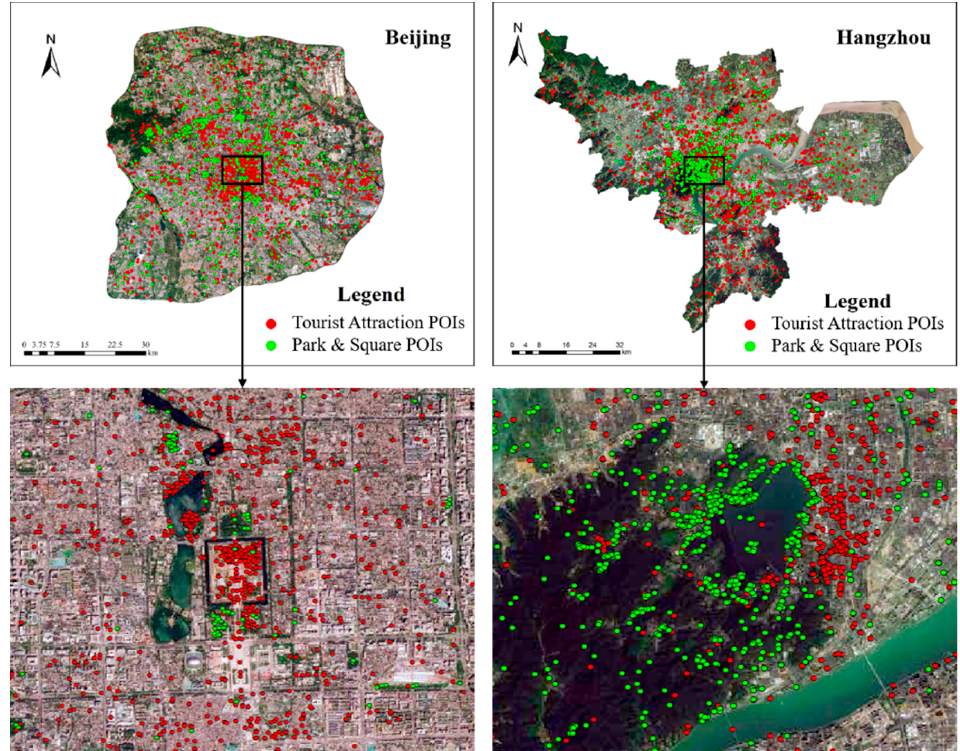
Figure 4. Points of interest (POIs) data of tourist attraction and Park and Square in Beijing and Hangzhou.